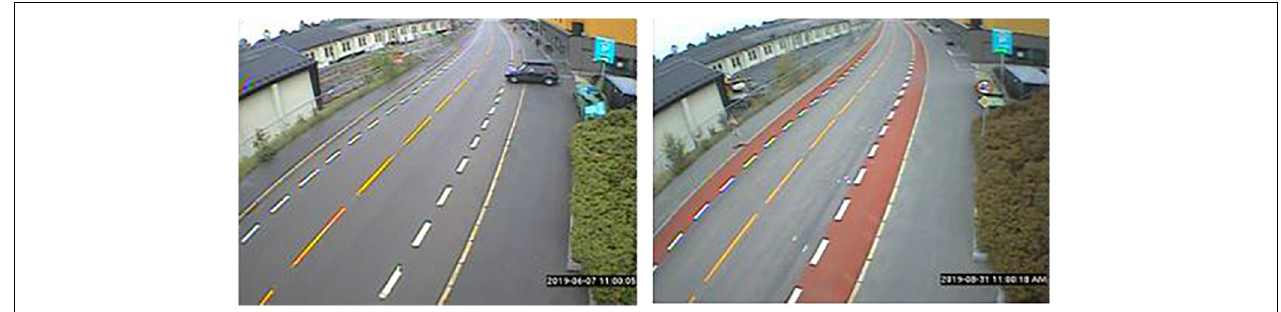
FIGURE 1 | Camera capture at Kongsveien before and after the cycle lane was recoated with red asphalt.